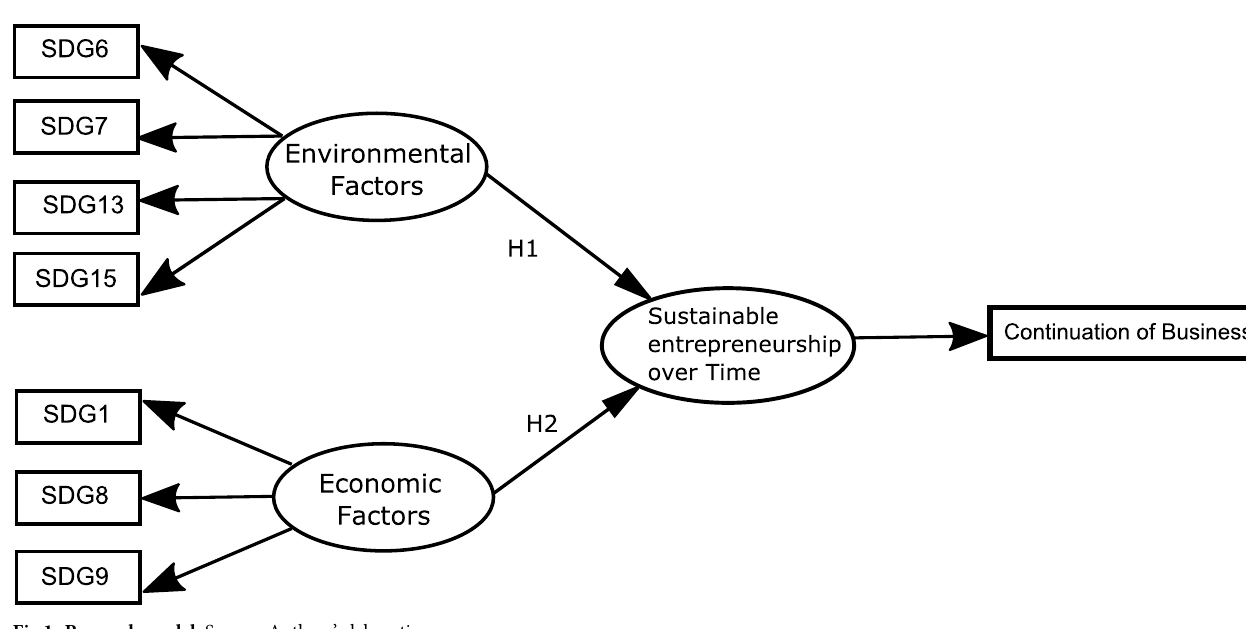
Fig 1. Research model. Source: Authors’